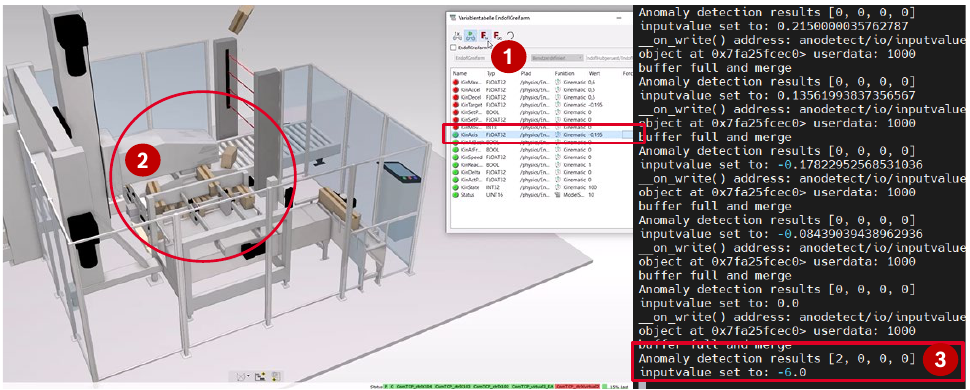
Figure 11. Manually initiated anomaly in the simulation environment and successful detection. 1. Manually forcing a faulty value (position gripper arm). 2. Visualization of abnormal behavior of the plant. 3. Successful detection by the anomaly detection algorithm on an edge